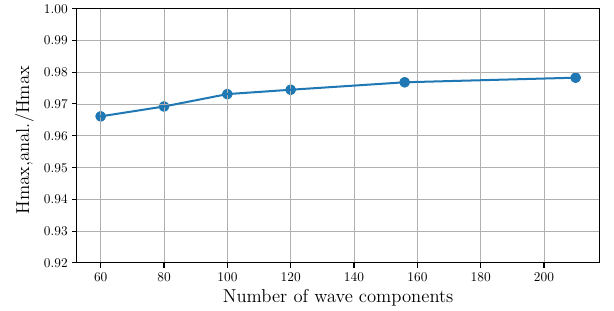
Figure 8. The study for the numerical wave components selection is shown. The maximum wave height, H max , for sea state 5a using as a reference the maximum wave height obtained from the analytical solution, H max , anal . , is provided as a function of the wave components, N .